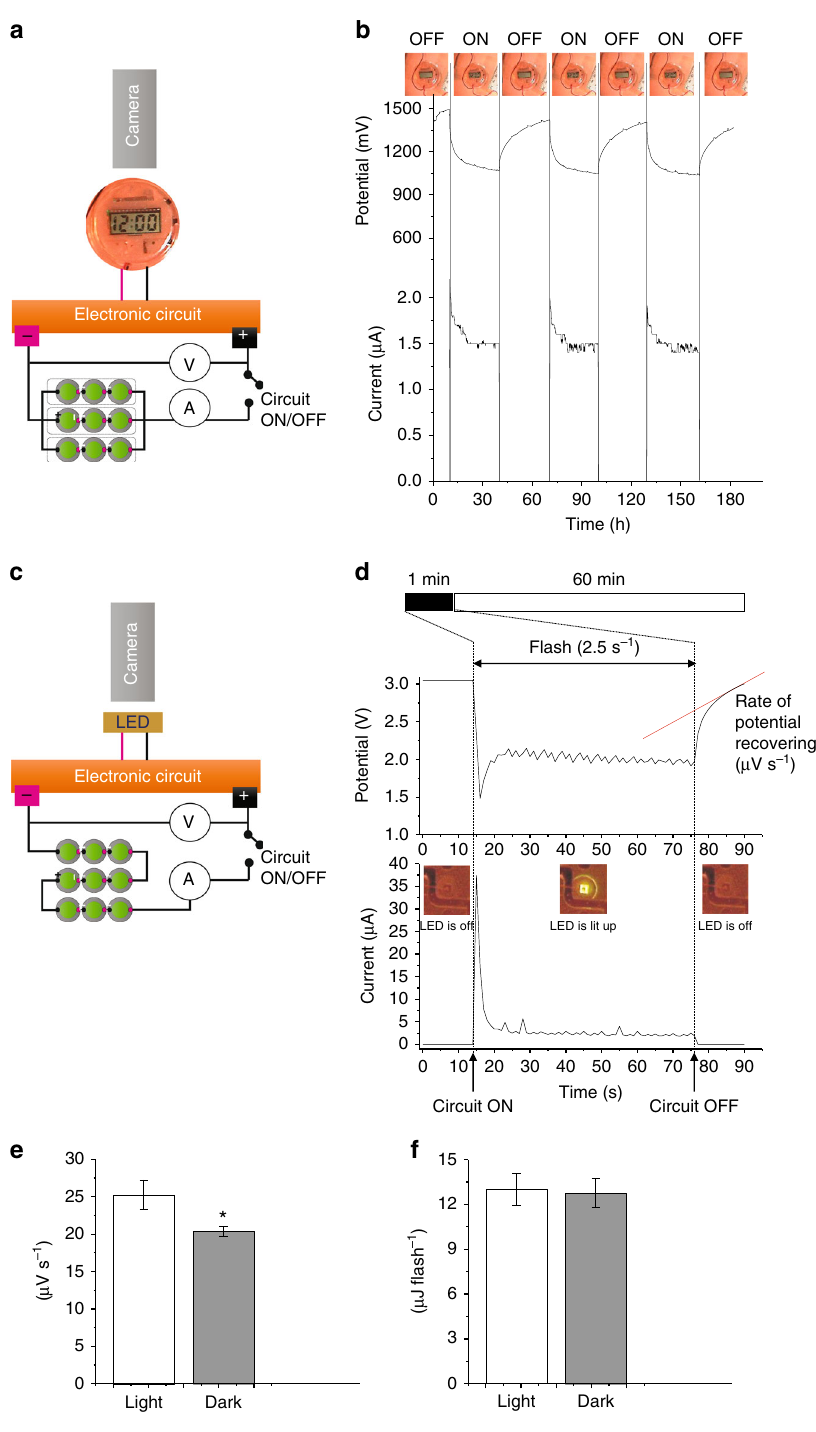
Fig. 4 Powering a clock and a LED- fl ash with an array of Hybrid BPV units. a Schematic representation of the experimental setup for the powering of a digital clock. An array consisting of 9 Hybrid BPV cells were organised in 3 clusters connected in parallel. Each cluster had 3 units connected in series. b Chronovoltammetric and chronoamperometric traces recorded during the experiment where the circuit ( i.e ., the digital clock) was either on ( i.e ., clock activated) or off ( i.e ., clock deactivated) for periods of approximately 30 min. c Schematic representation of the experimental setup for the powering of a LED. The array was organised all in series. d Chronovoltammetric and chronoamperometric traces recorded during the experiment where the circuit with its integrated LED was either on ( i.e ., pulsing every 2.5 s to activate the LED) for periods of approximately 60 s or off ( i.e ., LED deactivated) for periods of approximately 1 h. Rate of voltage recovery was estimated by fi tting the last 7 s of data with a linear regression line (in red); e kinetics of recovering to the original voltage following LED pulse when the BPV array was kept in the dark and when it was exposed to light; f average energy consumed for each LED